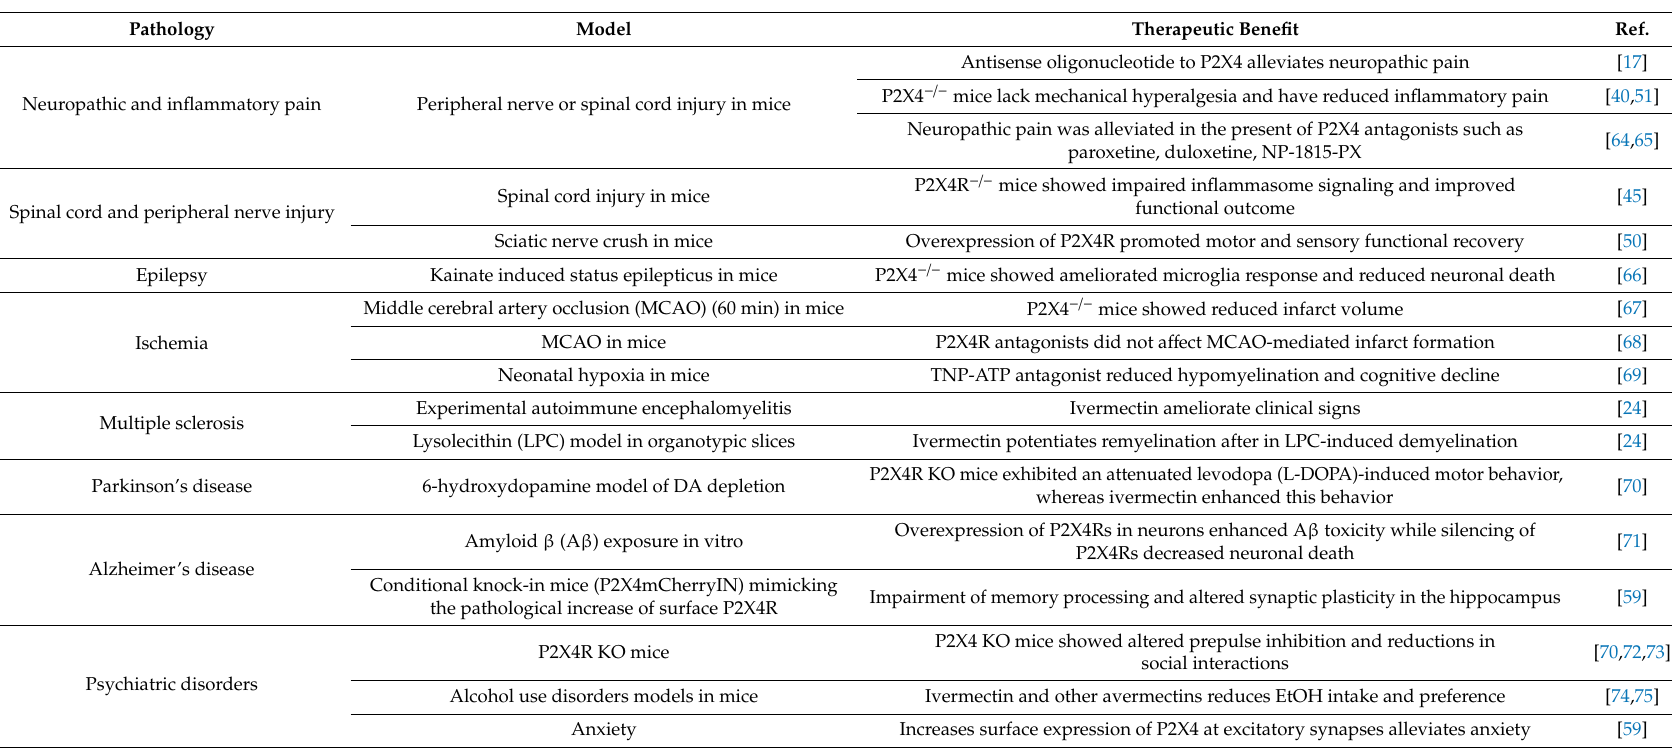
Table 1. Therapeutic potential of P2X4 modulators, antagonists or allosteric modulators in CNS